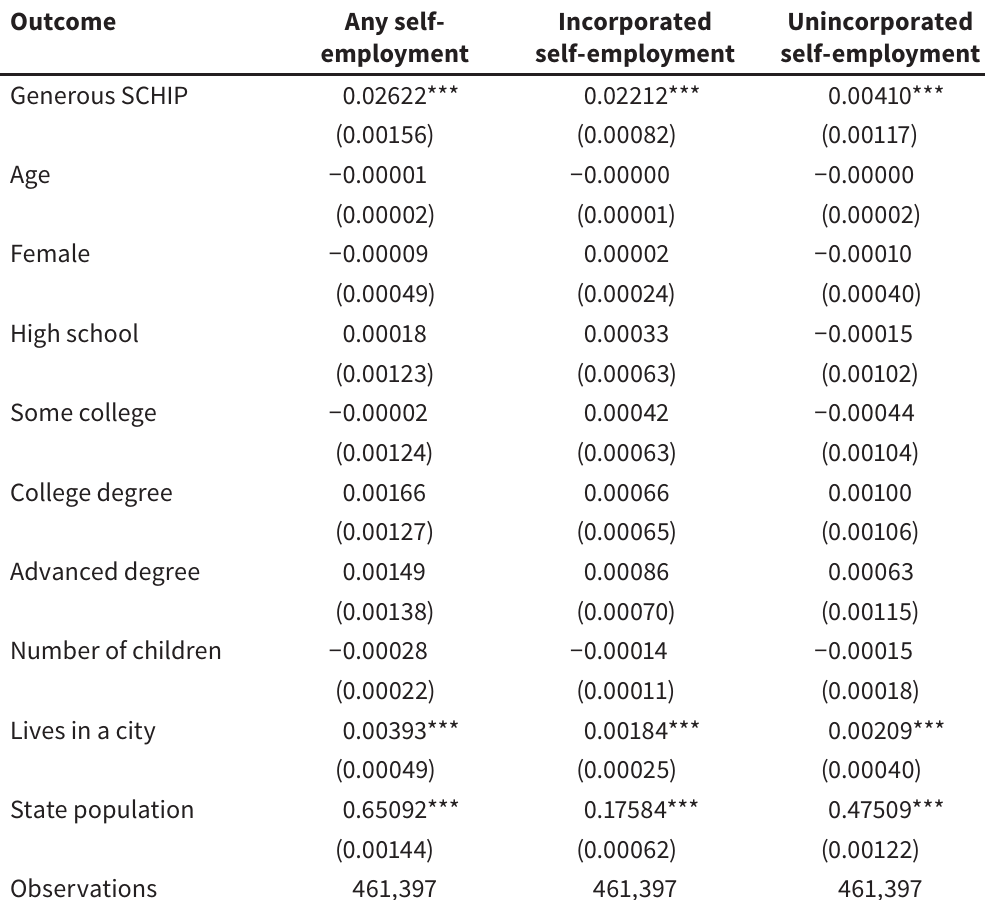
Heterogeneity in the Impact of Immigrant Entrepreneurs across Races of